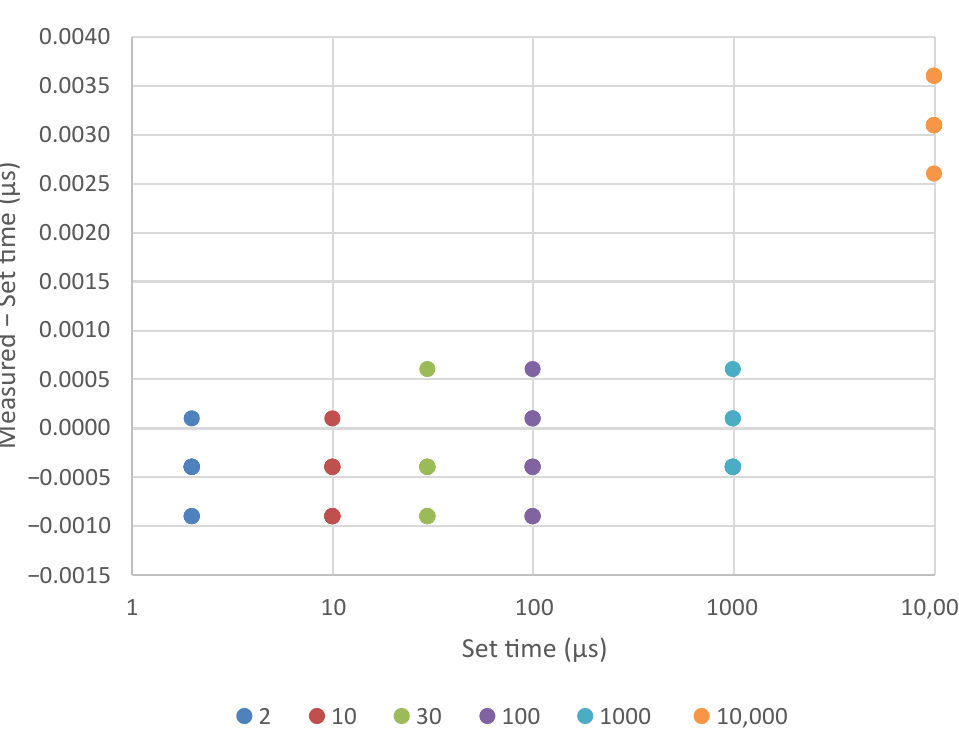
Figure 7. Set of 10 repeated measurements using OCXO.